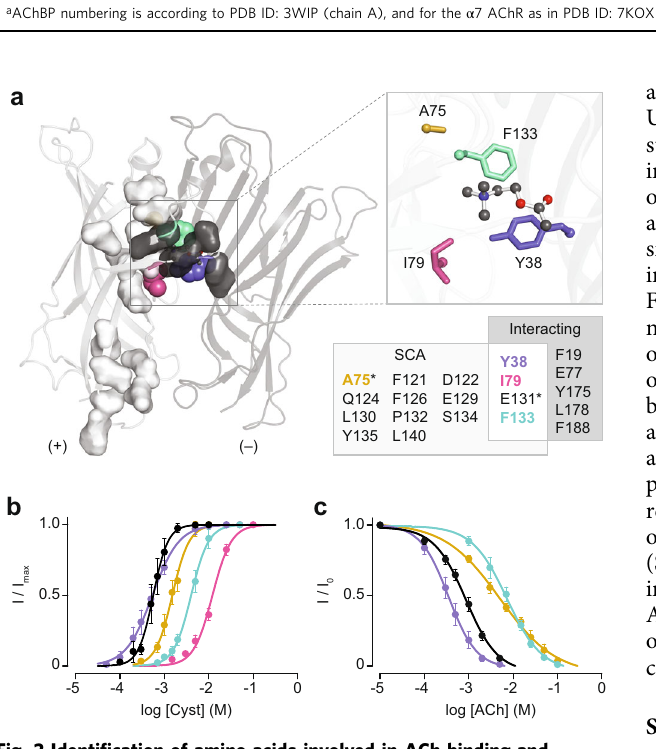
Fig. 2 Identi fi cation of amino acids involved in ACh binding and antagonism. a Crystal structure (PDB ID: 3RQW) 10 of ELIC in complex with ACh (ball and sticks), where the extracellular domain of the principal ( + ) and complementary ( − ) subunits are shown as cartoons and coloured light and dark grey, respectively. Residues identi fi ed by statistical coupling analysis or directly interacting in the structure are shown as light and dark grey surfaces, respectively. The four candidate residues for installing ACh agonism are shown as spheres, with A75, I79, and F133 on the principal subunit, and Y38 on the complementary subunit, coloured orange, magenta, green, and purple, respectively. These four residues are highlighted in the boxed inset on the right, and represented as sticks. A Venn diagram (below inset) shows the residues identi fi ed by statistical coupling analysis (SCA) and directly interacting with agonist in the structure (Interacting). E131 (asterisk) was not mutated since it has been identi fi ed as important for ACh binding in ELIC 10 , while A75 (asterisk) was mutated since this position has been shown to be important for ACh binding in the AChR 26 . b Dose response curves of cysteamine-activated wild-type ELIC (black), as well as the Y38W (purple), A75D (orange), I79Y (magenta) and F133W (green) mutants. c Inhibitory ACh dose response curves in the presence of EC 50 cysteamine for the wild-type and mutants (excluding I79Y) are coloured as in ( b ). Error bars in ( b , c ) represent one standard deviation from the mean, obtained from a minimum of 6 independent oocyte